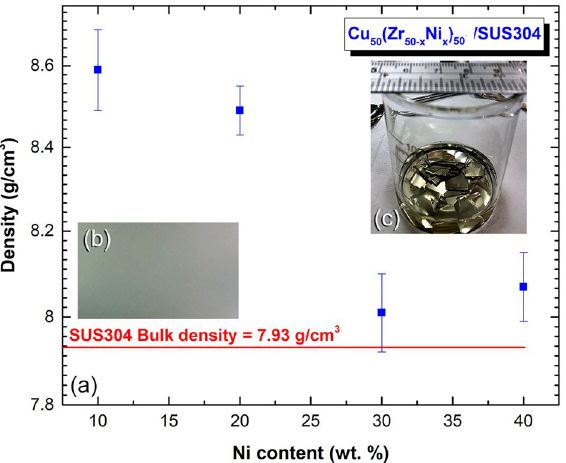
Figure 16. ( a ) Measured bulk density of MG-Cu 50 (Zr 50−x Ni x ) 50 coated/SUS304. The SUS304 substrate before and after cold spray coating are displayed in ( b ) and ( c ), respectively.